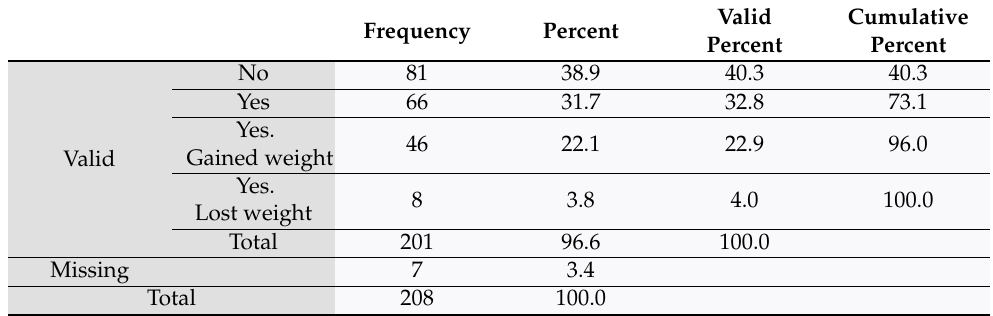
Table 4. Did you notice a change in your weight during the COVID-19 pandemic?